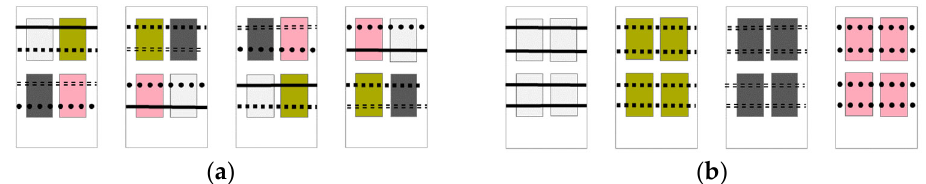
Figure 1. Overview of the treatments: ( a ) multi-choice, with all four types of litter and perches presented in each pen, and ( b ) single-choice, with only one type of litter and perch type per pen. The location of each litter and perch type was balanced across the four multi-choice pens, to control for potential effects of position within the pen on chick usage. Furthermore, each litter and perch type in the multi-choice pens was represented in a single-choice pen. In this way, we could account for any potential effects of specific perch and litter types, since our aim was not to explore the effects of the different litters and perches themselves, but the effects of increased choice per se.